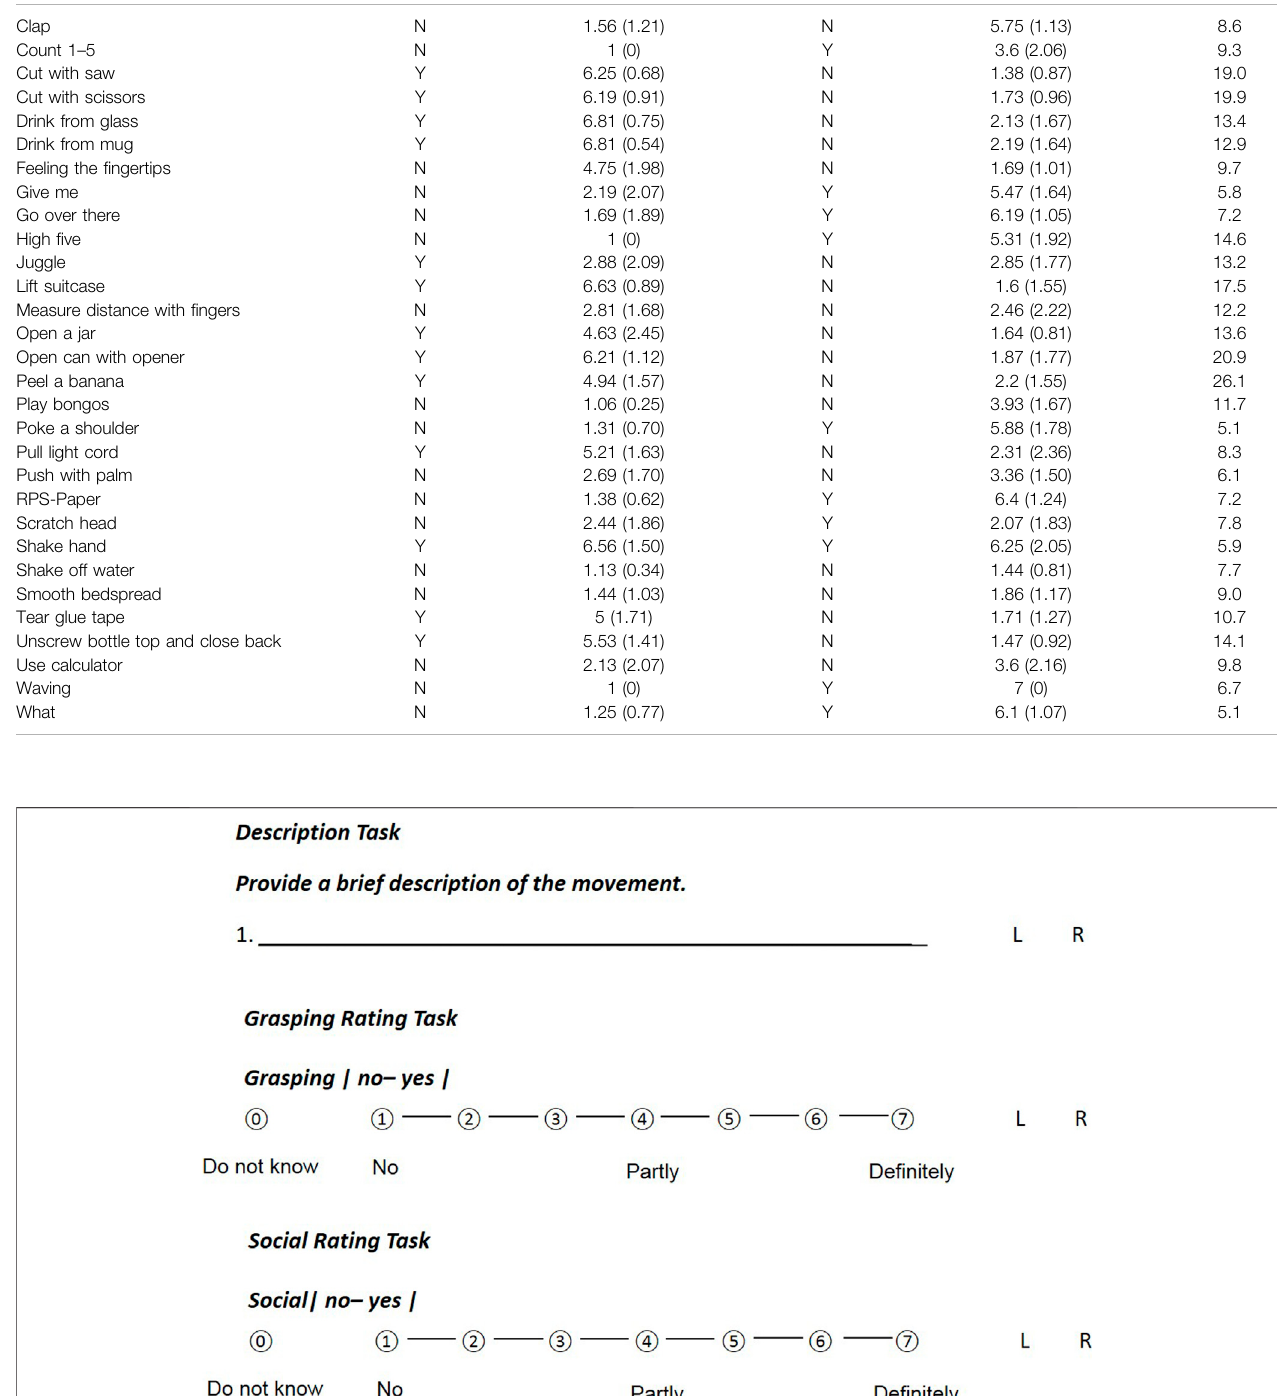
Frontiers in Robotics and AI |